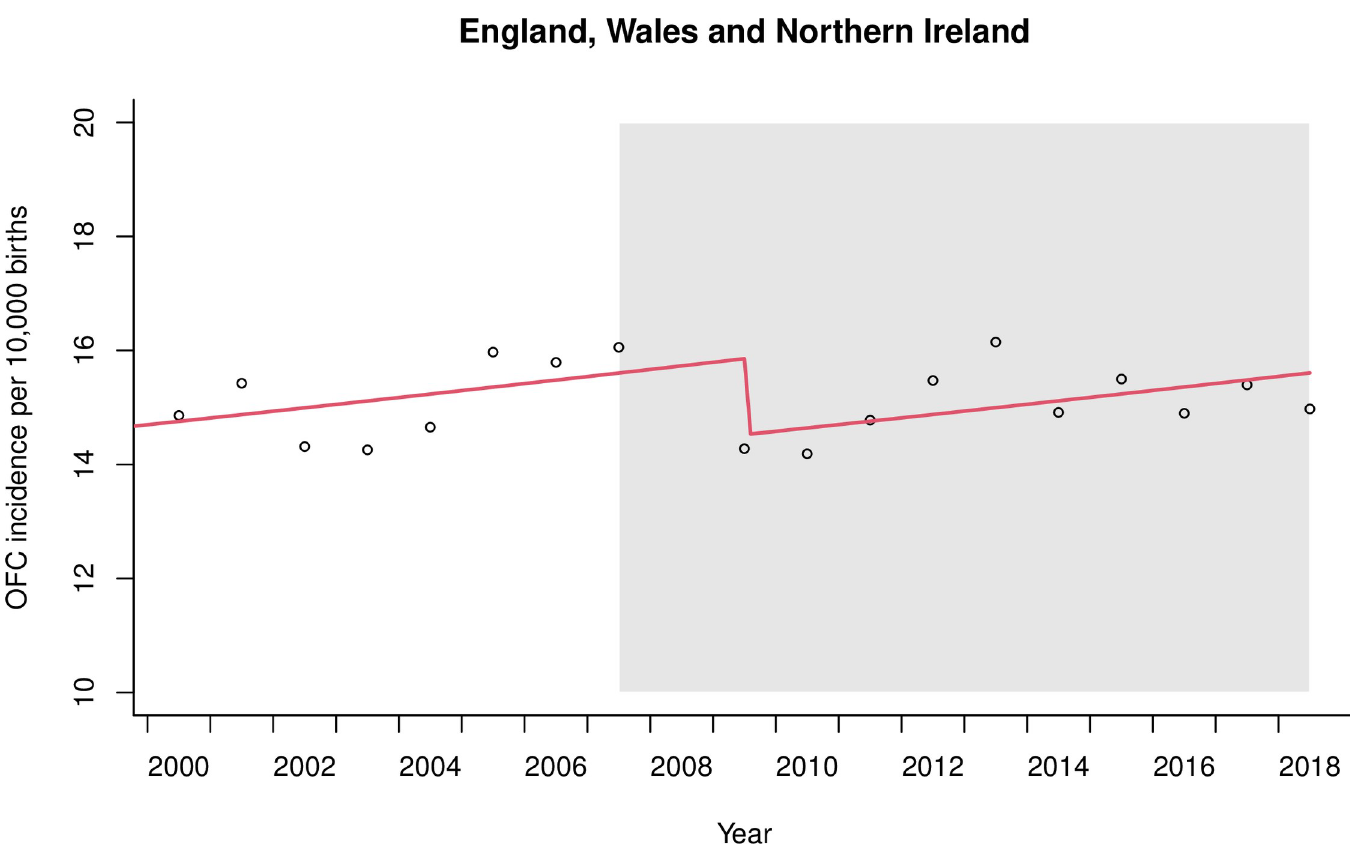
Fig 4. Interrupted time series regression analysis of orofacial cleft (OFC) incidence in England, Wales and Northern Ireland. Smoke-free legislation to prohibit smoking in the workplace and enclosed public spaces was implemented in 2007 and the period following is shaded in grey. Data from 2008 were omitted from the regression due to involvement in the lag phase. The first post-legislation datapoint was